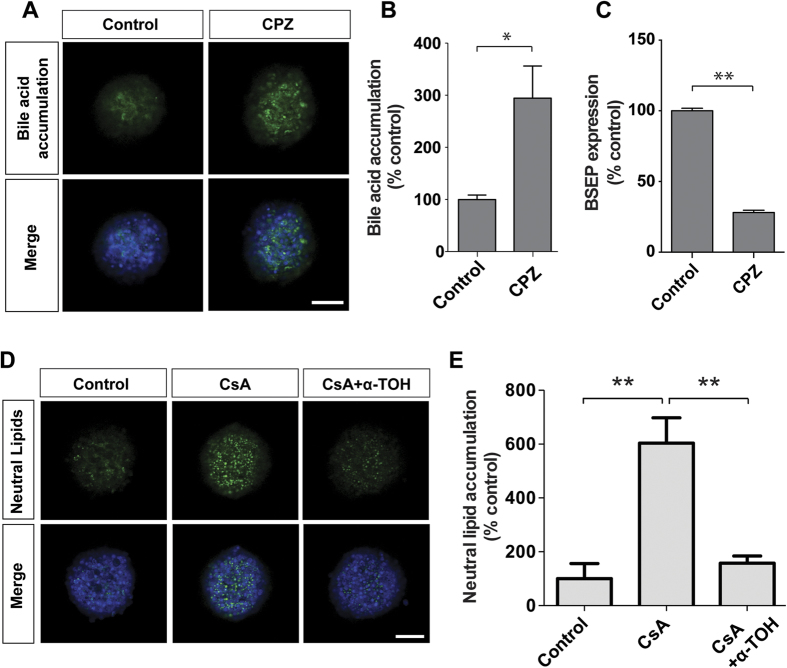
PHH spheroids as a model for cholestatic and steatotic disease.(A–C) Treatment with the cholestatic drug chlorpromazine (CPZ, 5 μM) caused significant accumulation (n = 3, p = 0.03) of the fluorescently-labelled bile acid derivative tauro-nor-THCA-25-DBD, which was associated with down-regulation of BSEP mRNA (C). (D,E) Cyclosporine A (CsA, 30 μM), a known inducer of steatosis in vivo45 increased levels of neutral lipids (n = 3, p = 0.003). Strikingly, cells were fully protected by co-exposure with the anti-oxidant α-tocopherol (α-TOH, 10 μM) (n = 3, p = 0.009). Bile acid and lipid accumulation were quantified and normalized to spheroid size using CellProfiler software. All scale bars = 100 μm. *indicates p < 0.05, **indicates p < 0.01.